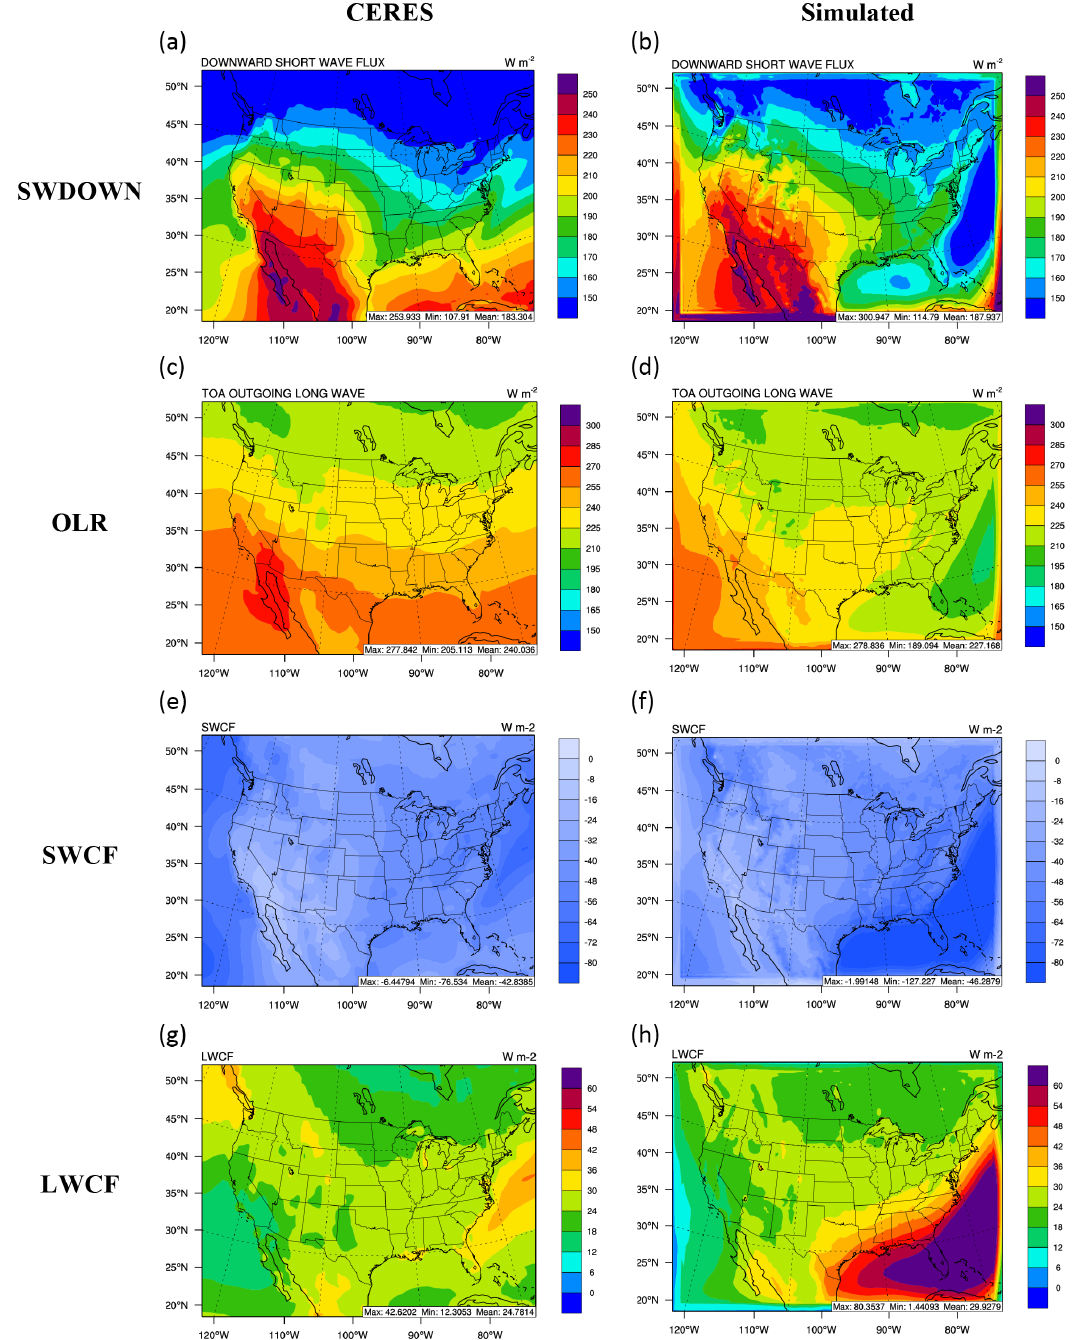
Figure 10. The 10-year averaged CERES (left) vs. simulated (right) SWDOWN ( a and b ), OLR ( c and d ), SWCF ( e and f ), and LWCF ( f and g